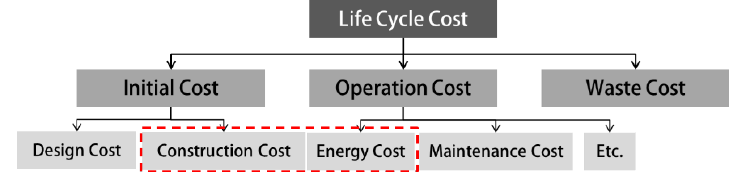
Figure 4. Research Scope of Life Cycle Cost Analysis.